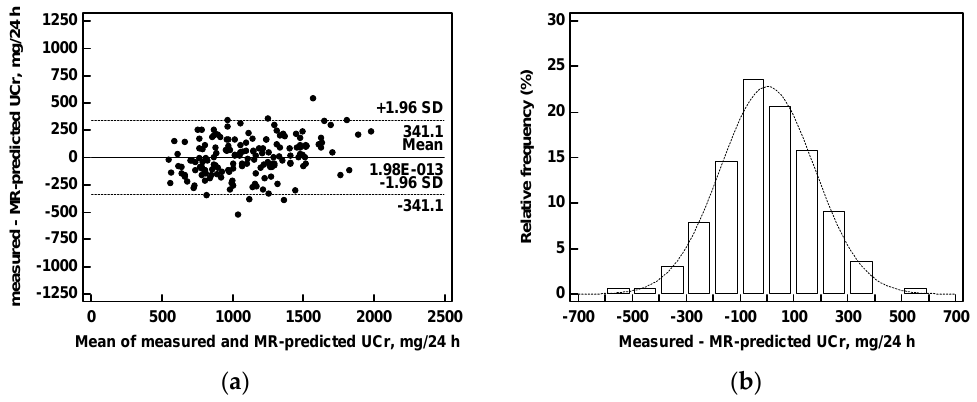
Figure 3. Measured versus predicted urinary creatinine excretion: ( a ) Agreement plot between measured 24 ‐ h urinary creatinine (UCr) and urinary creatinine predicted from BCM and multiple regression analysis equation (MR ‐ predicted UCr), and ( b ) histograms of frequency distribution of the differences between measured and predicted UCr.